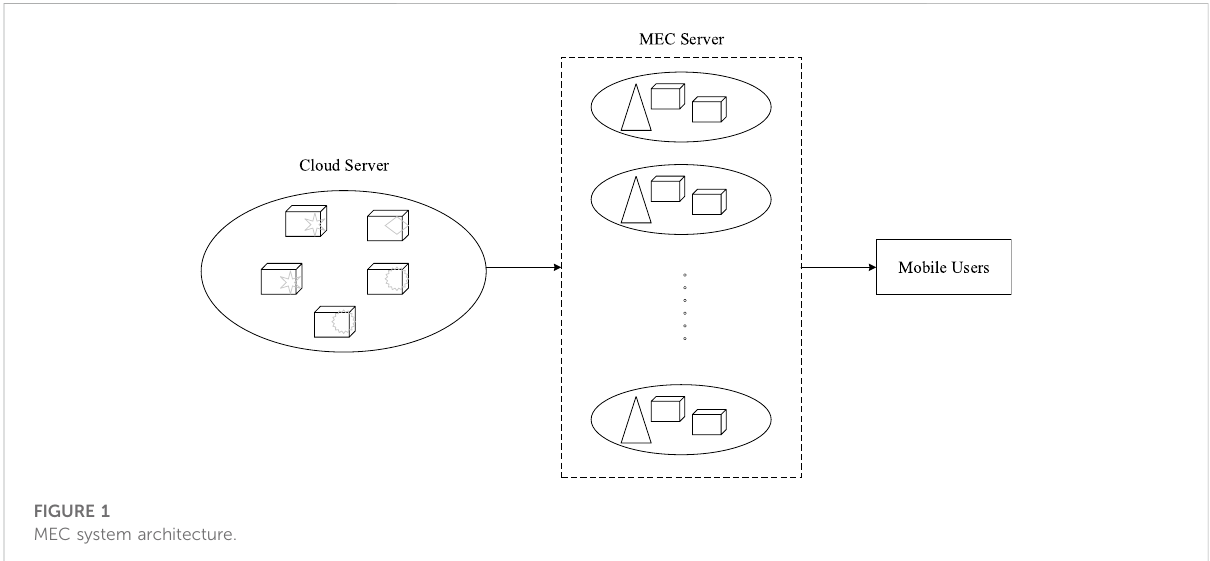
FIGURE 1 MEC system